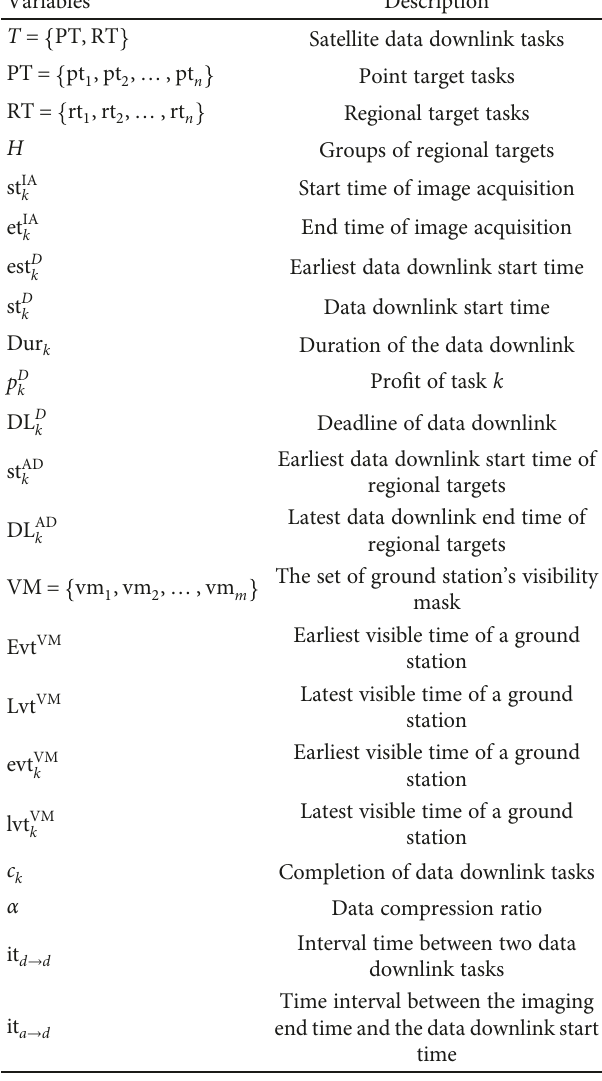
Table 1: Variable